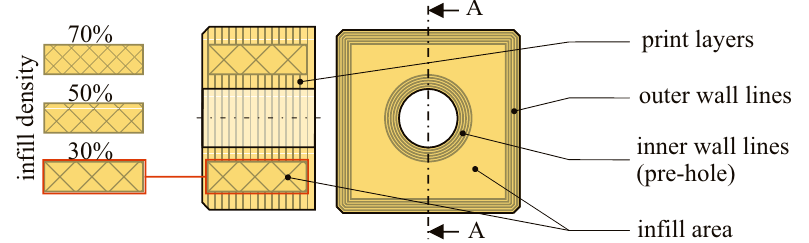
Figure 2. Schematic illustration of the FLM test